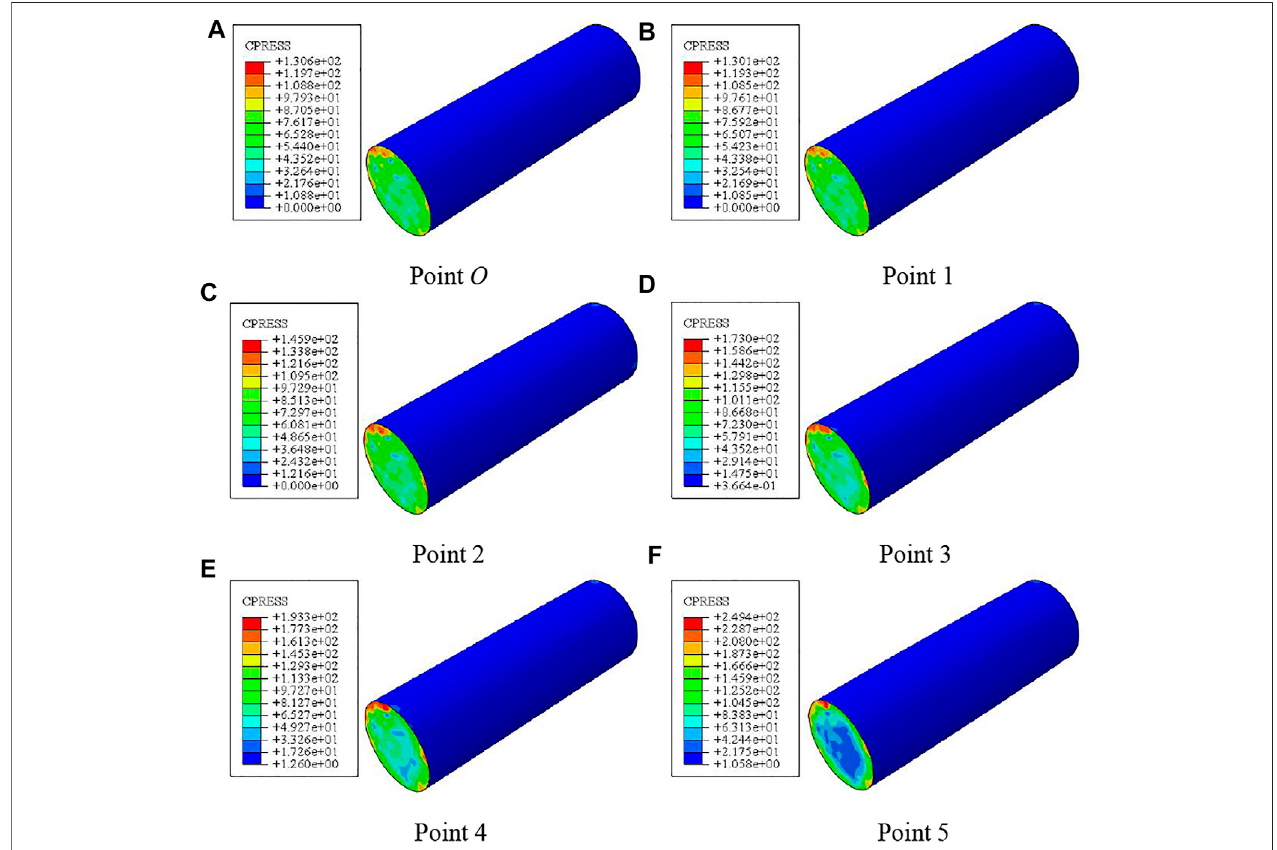
FIGURE 19 | Distribution of interaction force between the steel tube and concrete. (A – F) Crack of Distribution of interaction force between the steel tube and concrete at different 0 – 5 points.